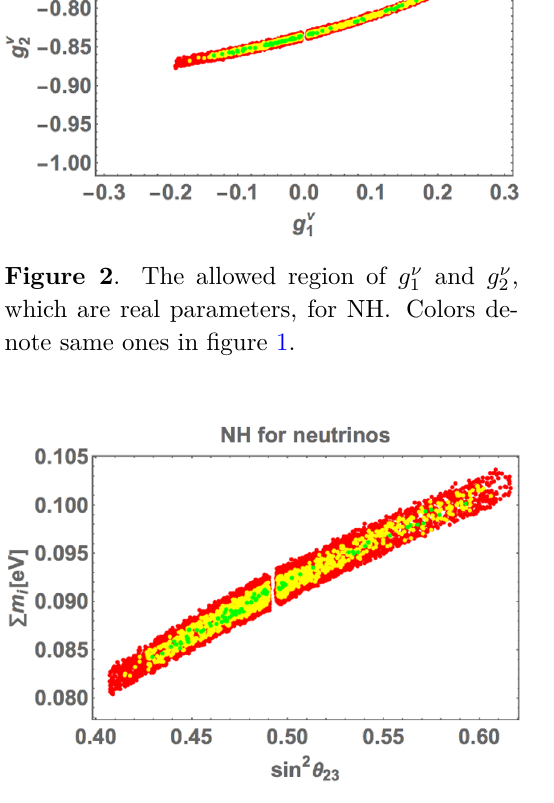
Figure 4 . The allowed region on sin 2 θ 23 – P m i plane for